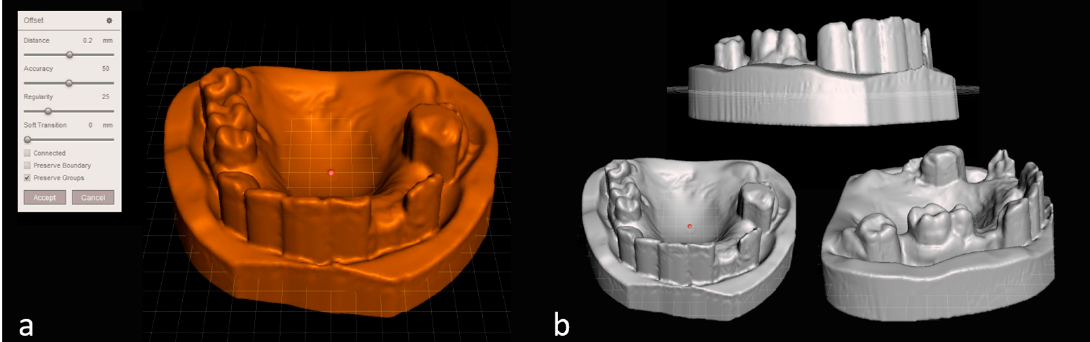
Figure 5. Finalizing the blocked-out maxillary digital cast. ( a ) A 0.2mm offset applied to the blocked- out cast to ensure passive fitting of the overlay. At this stage, the reference blocked-out cast must be deleted by inverting the selection. ( b ) A finalized maxillary blocked-out cast.